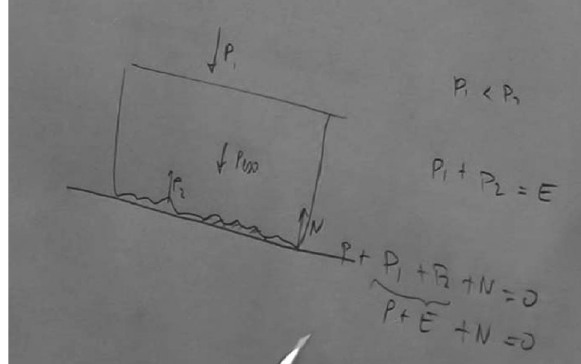
FIG. 7. Model proposed by the students from a “ microscopic ” point of view. ( P 1 and P 2 are pressures, P is weight, N is normal force, and E stands for